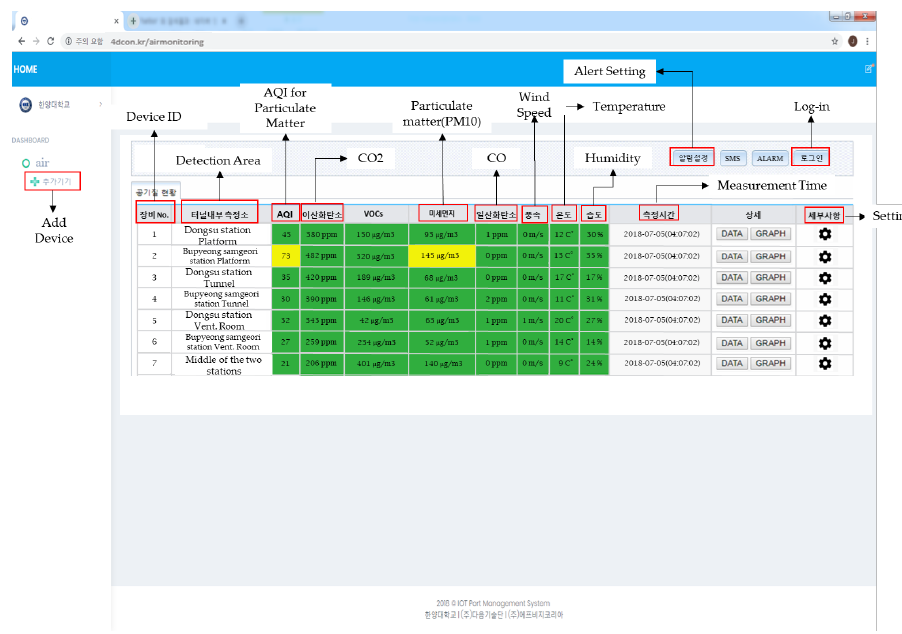
Figure 5. Cloud computing web server of the IoT-based air quality monitoring system.